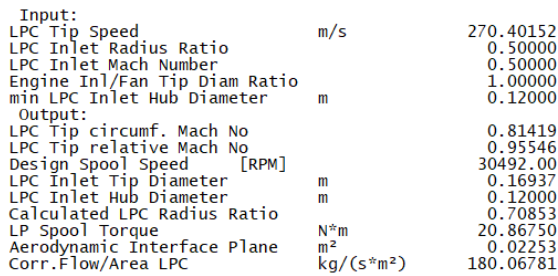
Figure A6. LPC design in GasTurb software for the annulus diameter 0.17 m.